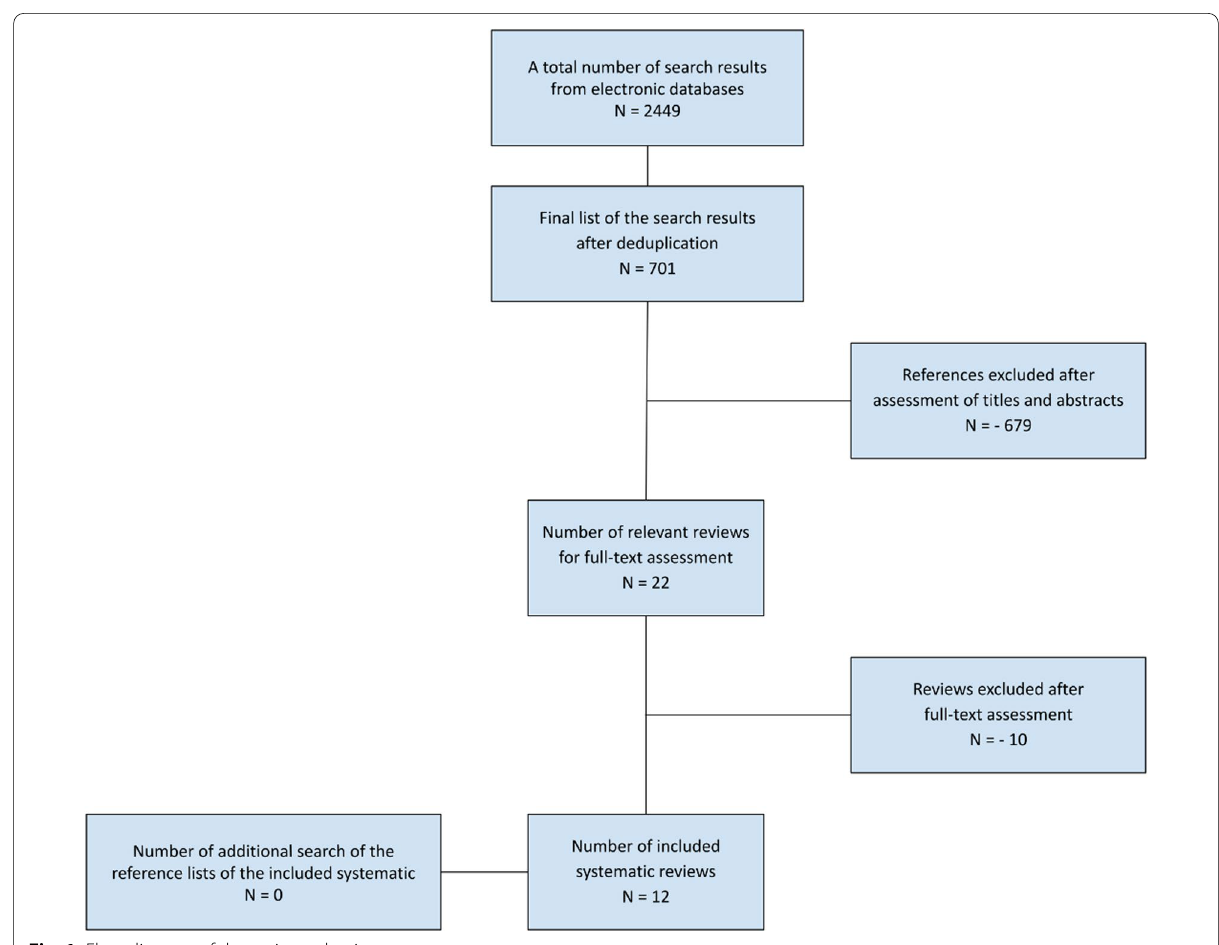
Fig. 1 Flow diagram of the review selection